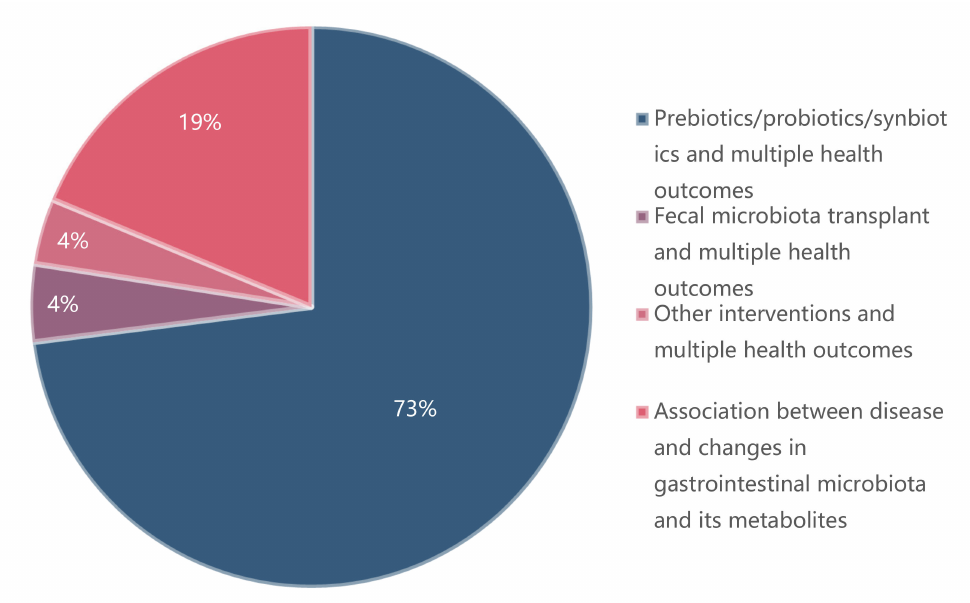
Figure 2. Map of outcomes related to the gastrointestinal